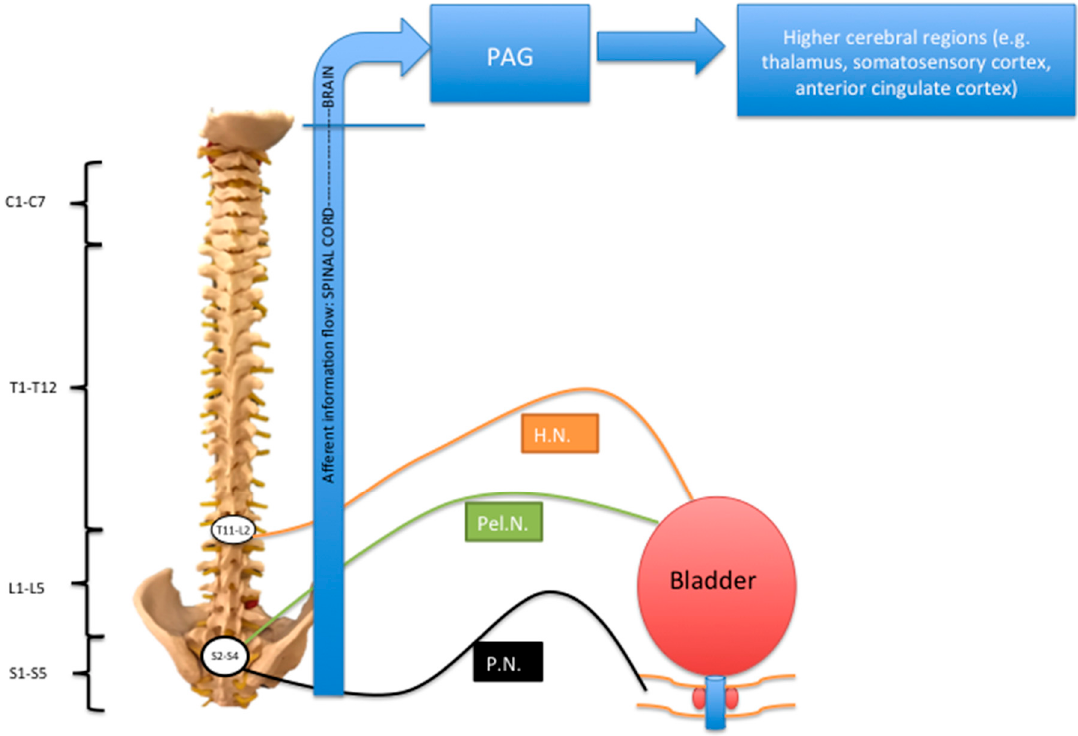
Figure 1 . P.N.: pudendal nerve; Pel.N.: pelvic nerve; H.N. hypogastric nerve; PAG: periaqueductal grey area. Schematic to summarize afferent innervation of the lower urinary tract. The sensory fibers traveling in the pelvic and pudendal nerves have their cell bodies in dorsal root ganglia (DRGs) at the S2–S4 level. Parasympathetic fibers travel in the pelvic nerve and sympathetic fibers travel in the hypogastric nerve. Modified from Reference [1].